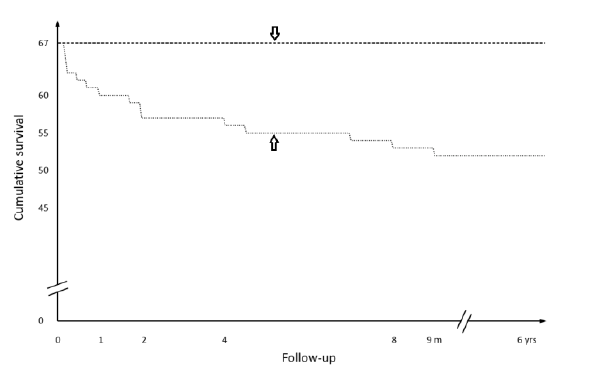
Figure 2: Kaplan-Meier survival curve showing the graph for patients undergoing emergency surgery for NEC (up-arrow) contrasted with those patients who had surgery for post-NEC stricture(s) (down-arrow).